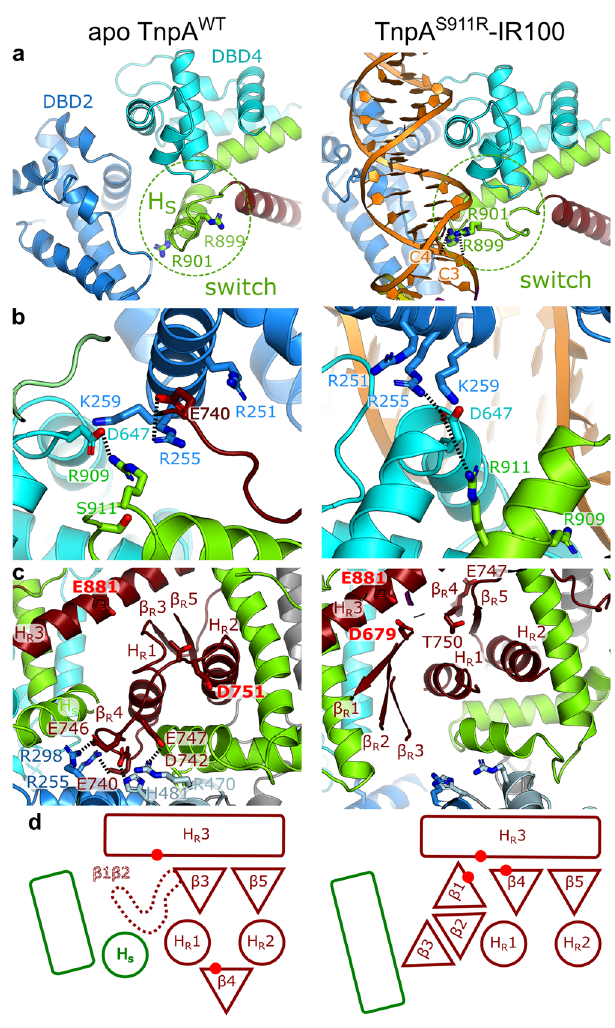
Fig. 5 | Details of conformational changes between apo and TnpA S911R - IR100 states. a Rearrangement of DBD2 relative to DBD4 and refolding of switch helix H S . The loop connecting H R 3 with H S caries two positively charged residues R899 and R901 that bind to cis-DNA. b Ionic lock, and salt bridge R911-D647 sta- bilizing the IR-bound conformation. c Metamorphic behavior of RNH domain that changes fold when switches from apo to IR-bound conformation. The catalytic residuesarelabeledinred. d Schematiccartoonshowingrearrangementofthefold of structural elements in the catalytic site that includes straightening of the switch helix, repositioning of strands β R 3 and β R 4 and folding of strands β R 1 and β R 2. The rectangles and circlescorrespond to α -helices,and triangles to β -strands.Red dots indicate the positions of the catalytic